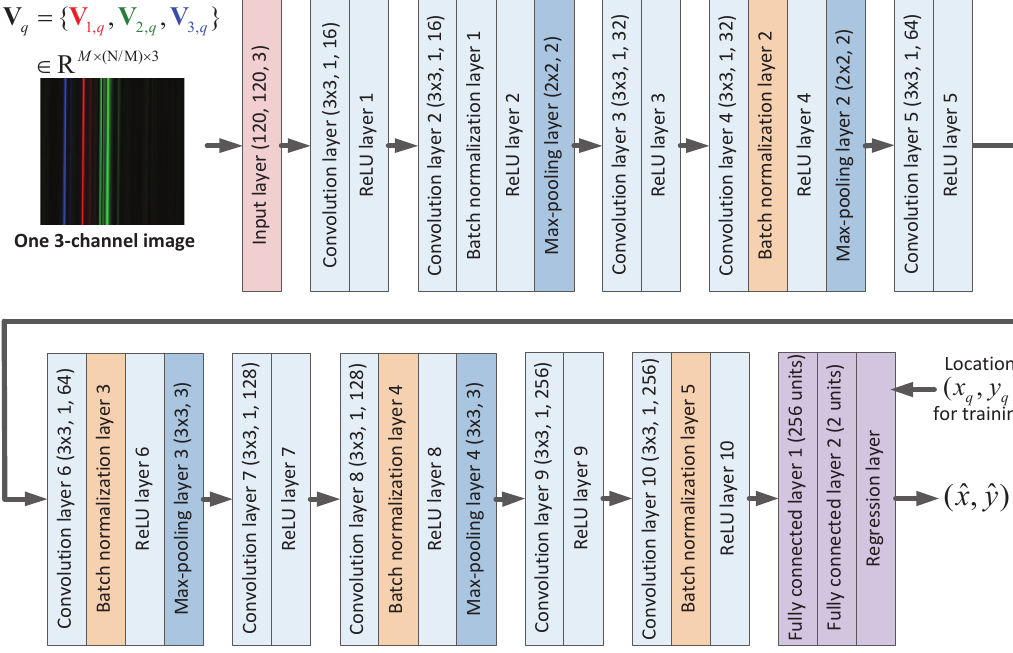
Figure 5. CNN model for the CNN-LE method. Only one CNN is required for the proposed CNN-LE method. The CNN can be implemented at any of three